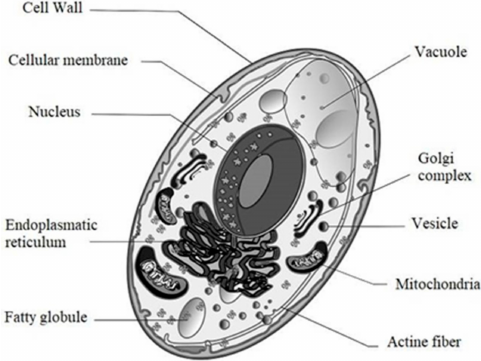
Figure 1. S. cerevisiae cell and organelles description.